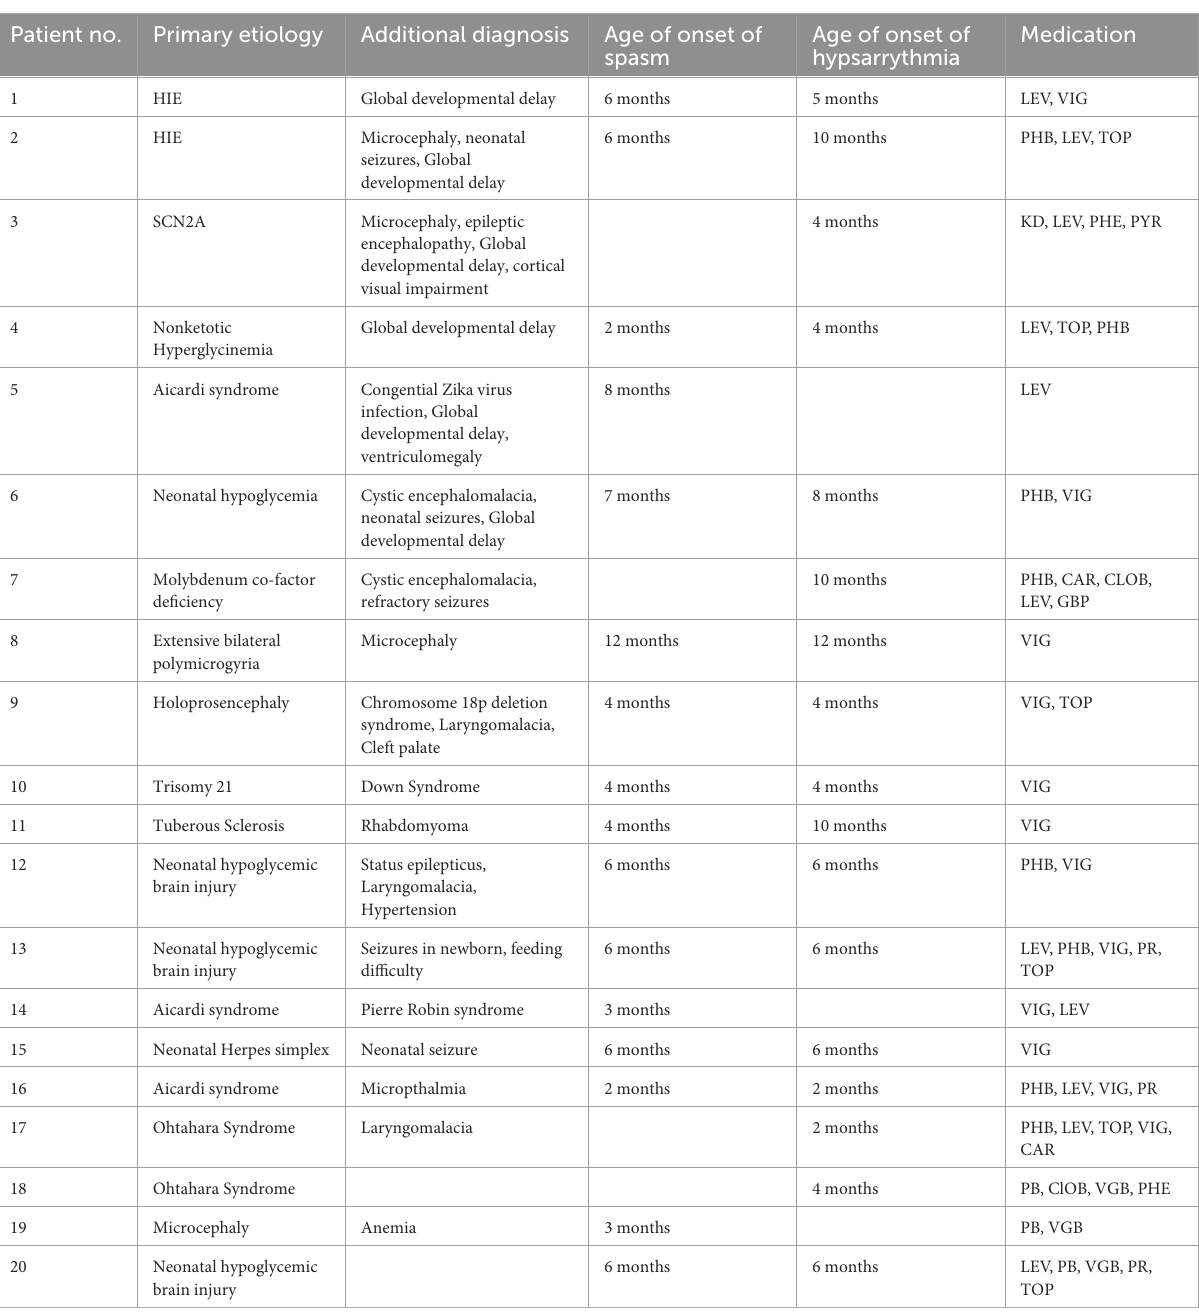
HIE, Hypoxic Ischemic Encephalopathy; LEV, Levitiracetam; PHB, Phenobarbitone; VIG, Vigabantrin; PR, Prednisolone; CAR, Carbamazepine; PHE, Phenytoin; TOP, Topiramate; KD, Ketogenicdiet;PYR,Pyridoxine;CLOB,Clobazam;GBP,Gabapentin.